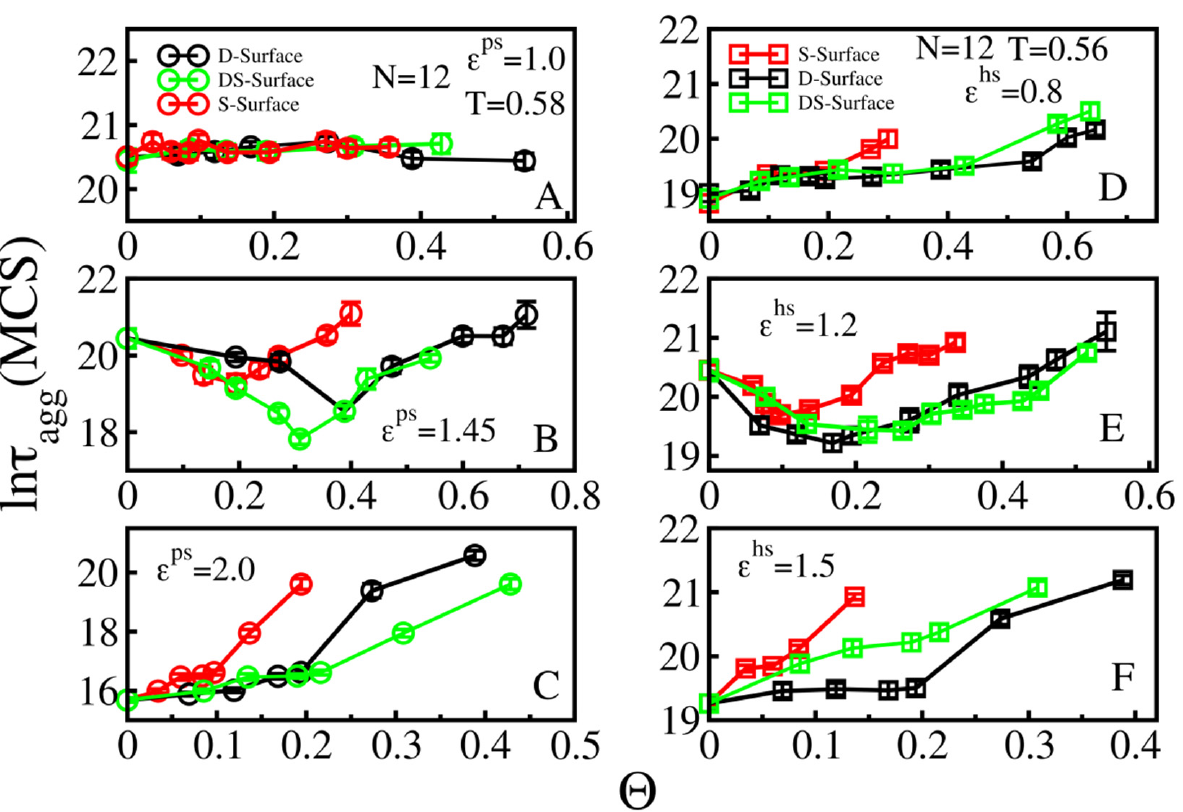
Figure 8. Dependence of ln τ agg on Θ of N = 12 peptides at T = 0.58 and 0.56 for hydrophilic ( left column ) and hydrophobic surfaces ( right column ). For hydrophilic surfaces, we considered ε ps = 1.0 (weak regime, A ), 1.45 (medium, B ), and 2.0 (strong, C ). For hydrophobic surfaces the corresponding values ε hs = 0.8 ( D ), 1.2 ( E ), and 1.5 ( F ).